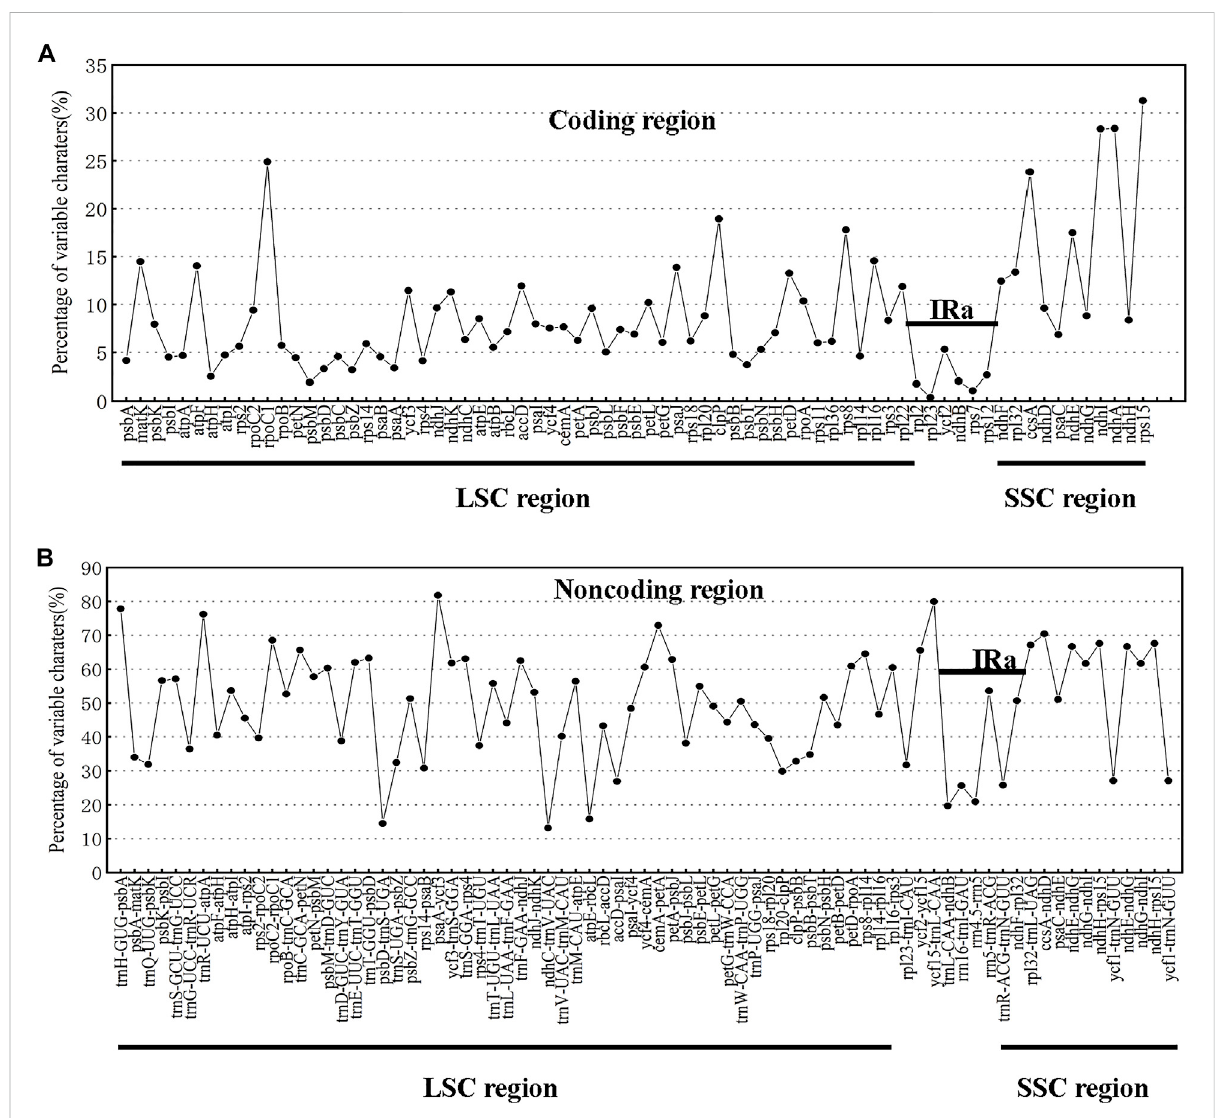
FIGURE 6 Percentages of variable characters in homologous regions among chloroplast genomes of 23 Swertia L. species. (A) Coding region. (B) Non- coding region. The homologous regions are oriented according to their locations in the chloroplast